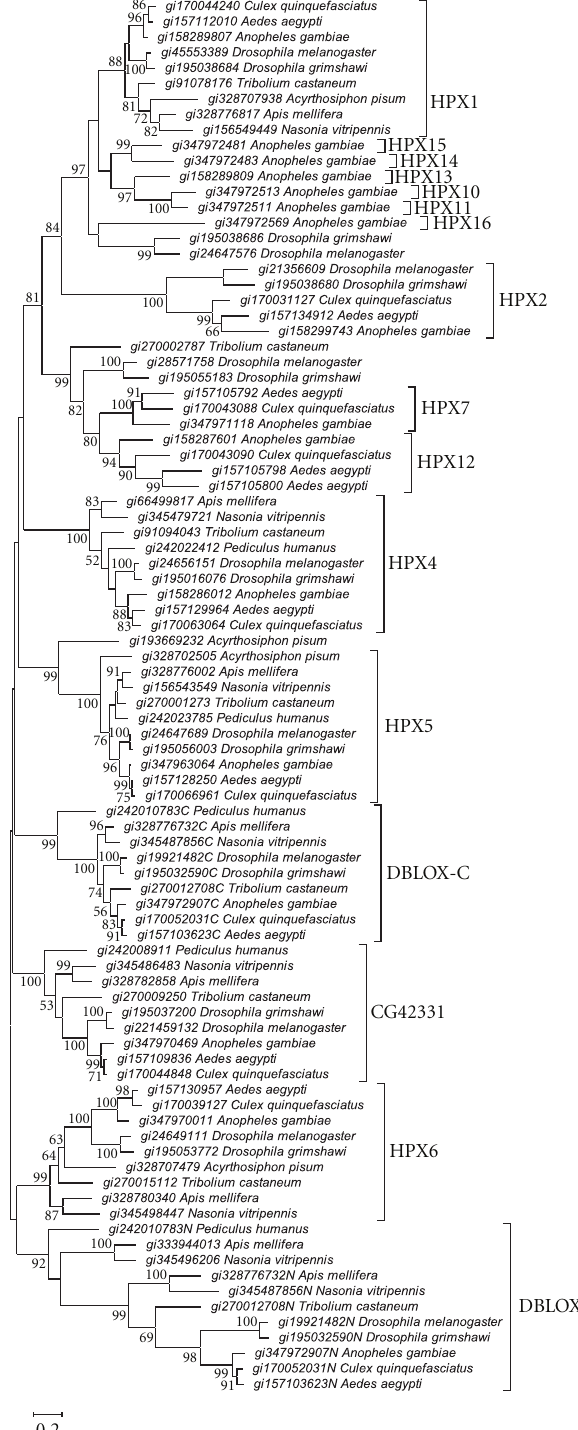
Figure 1: Maximum likelihood tree of insect heme peroxidases, based on the WAG+G+I model at 301 aligned amino acid sites. Numbers on the branches represent the percentage of 1000 bootstrap pseudosamples supporting the branch; only values ≥ 50% are